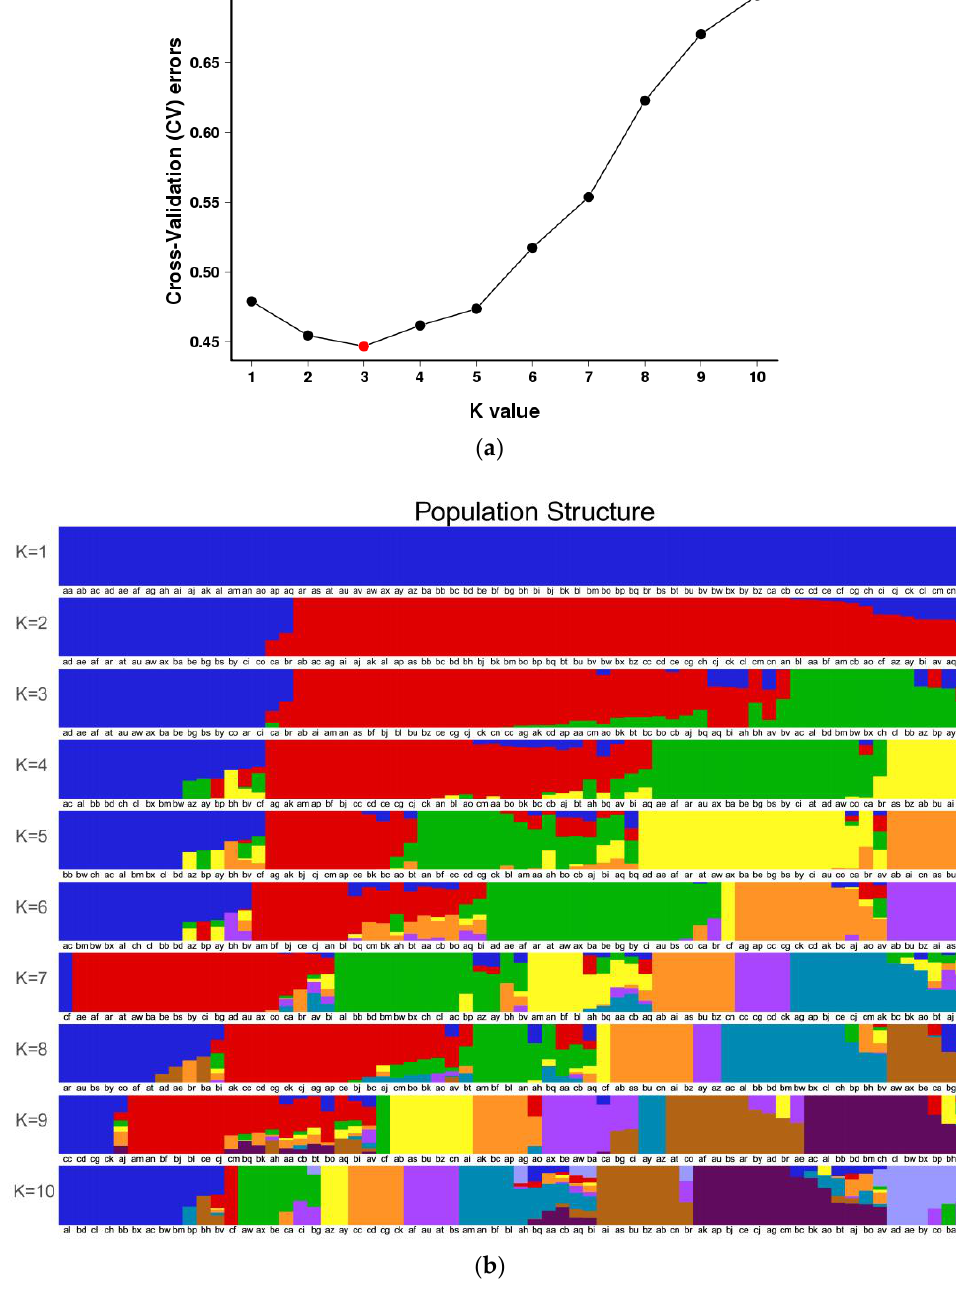
Figure 2. Population structure analysis of S. nigrum with the ADMIXTURE program using genome- wide SNP markers ( n = 616,533). ( a ) The estimated cross-validation errors for different grouping results (K value); ( b ) The individuals were divided into three subgroups (there was a minimum K-value when K = 3), within each subgroup, the individuals were ordered according to the genetic component, and each line gives the sub-group value, with each accession shown as a vertical line partitioned into K colored components representing inferred membership in K genetic clusters.